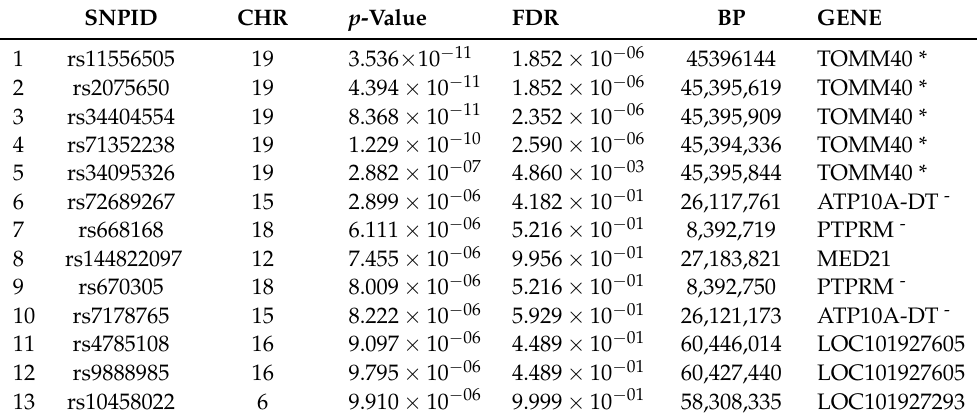
Table 2. Detailed information of significant SNPs with p ≤ 1 × 10 − 05 (sorted by p -value from smallest to largest). We marked the genes associated with dementia using (*) and a series of novel genes related to brain development or neurodevelopment using